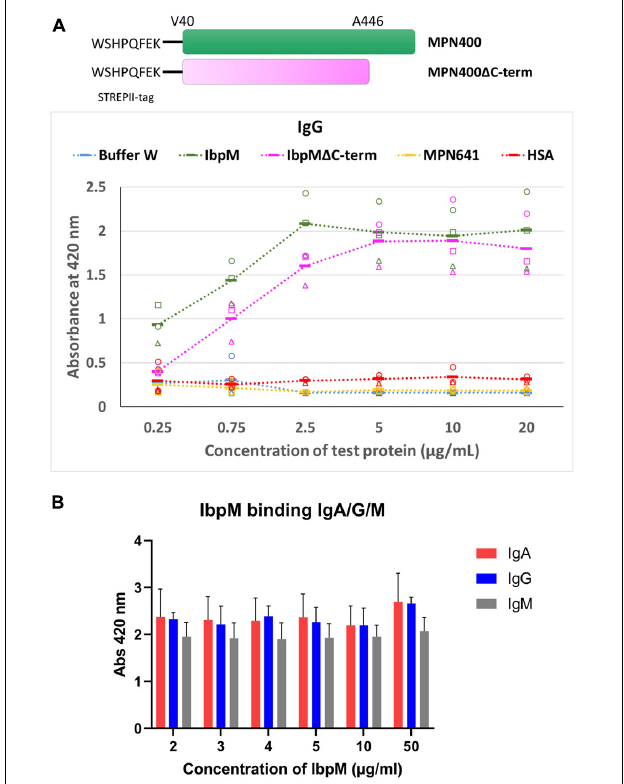
FIGURE 6 | Binding of different Ig’s toward IbpM in an ELISA experiment. (A) Purified full-length IbpM, C-terminal truncated IbpM, and human serum albumin (HSA) were coated in different concentrations onto 96-well plates and incubated with IgG, IgA, or IgM. Binding of Ig’s was quantified by the detection with rabbit α -human Ig-AP antibody responsible for ABTS color formation and detection at 420 nm. Squares, circles, and triangles, each indicate a biological replicate mean, each biological replicate itself consisting of three technical replicates. The solid bar represents the average of all measurements. Full-length IbpM in green, truncated IbpM in pink, and HSA in orange. Values from IgG measurement in the graphic are representative as well for IgA and IgM (for graphs of IgA and IgM binding please refer Supplementary Figure S1 ). (B) Binding profiles of full length IbpM to IgA, IgG, and IgM.